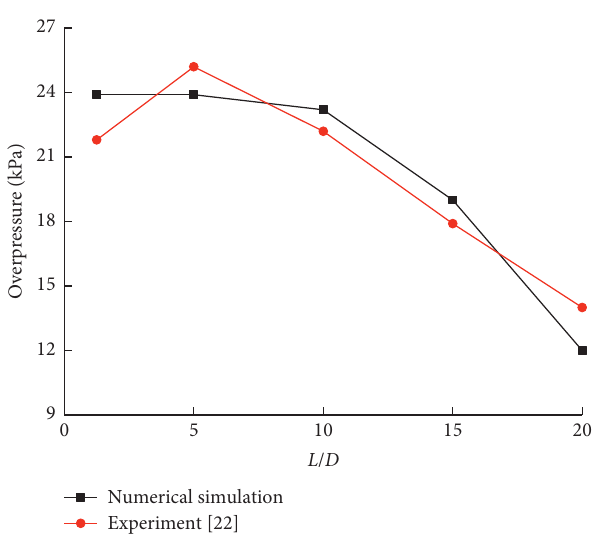
Figure 2: Comparison curve of numerical simulation and ex- perimental peak overpressure.